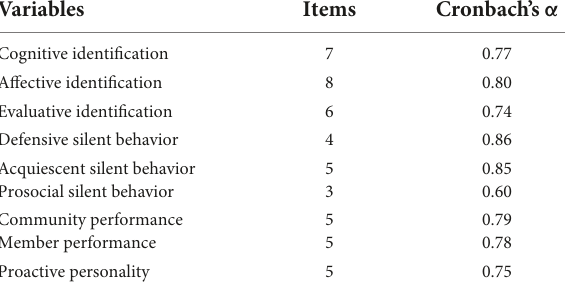
TABLE 2 The results of reliability